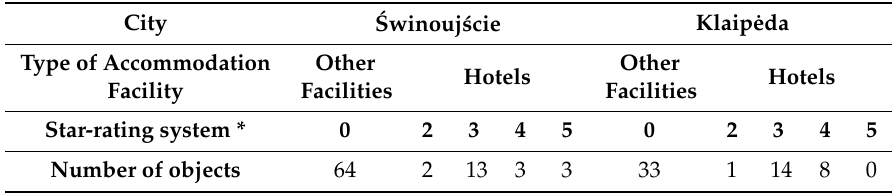
Table 2. Number of establishments by the type of accommodation